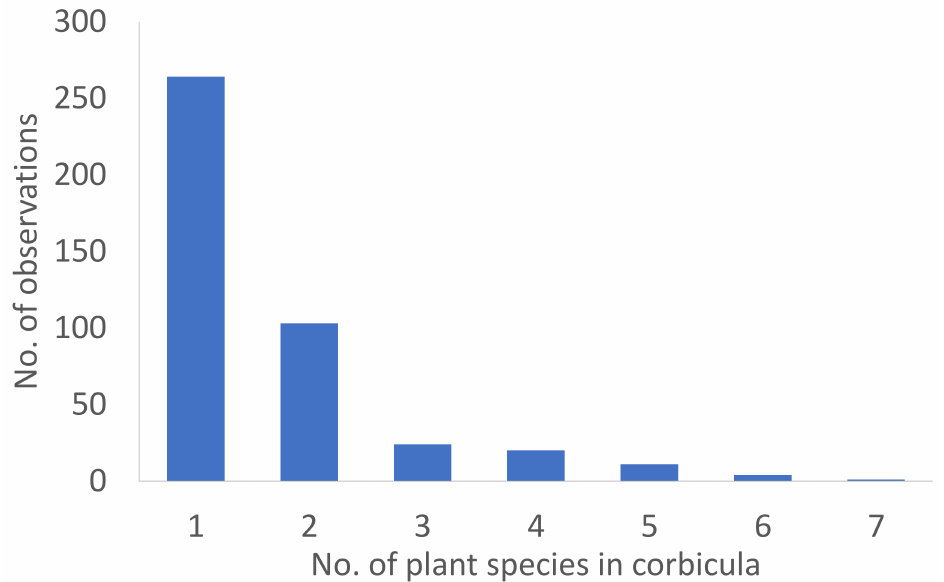
Figure 4. The number of bumble bee corbicular pollen loads containing a different number of plant